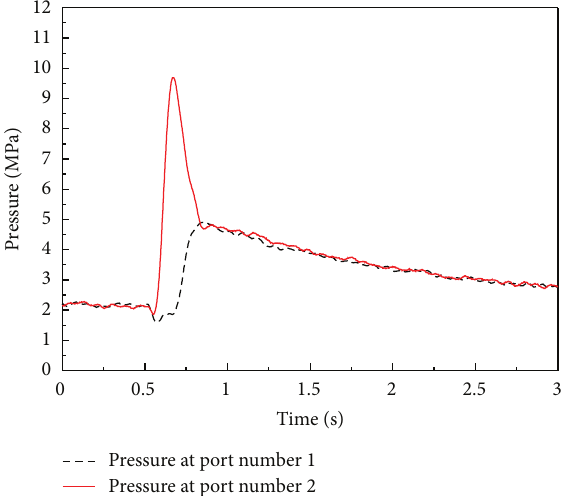
Figure 17: Pressure variations of optimal PID position control system for EHA with load